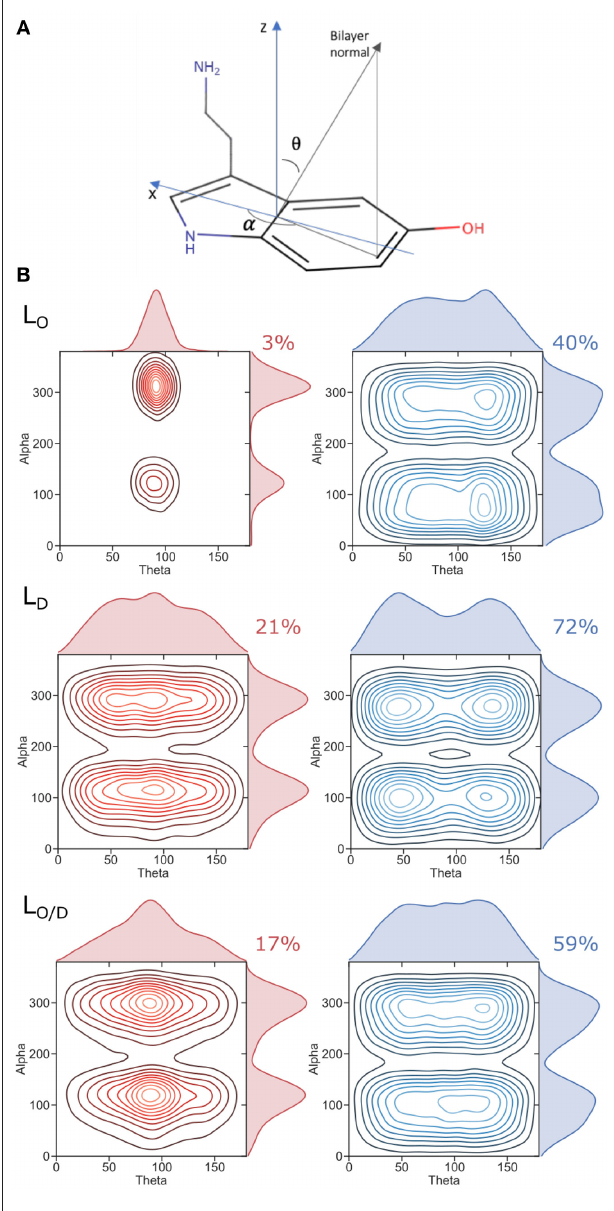
FIGURE 5 | Serotonin orientation in the bilayer. (A) Axis framework used to define the orientation of serotonin. (B) Plots showing the population of observed angles used to describe the orientation of serotonin for the respective phases ( L O , L D , L O / D ). Red plots (left) correspond to serotonin molecules residing in the hydrophobic core of the bilayer, whereas blue plots (right) correspond to those located within the lipid headgroup region. The percentages of serotonin residing at the hydrophobic core of the bilayer or within the headgroups is also reported.